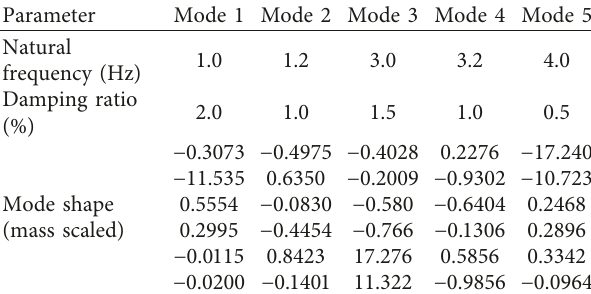
Table 1: Modal participation vector estimates for the first